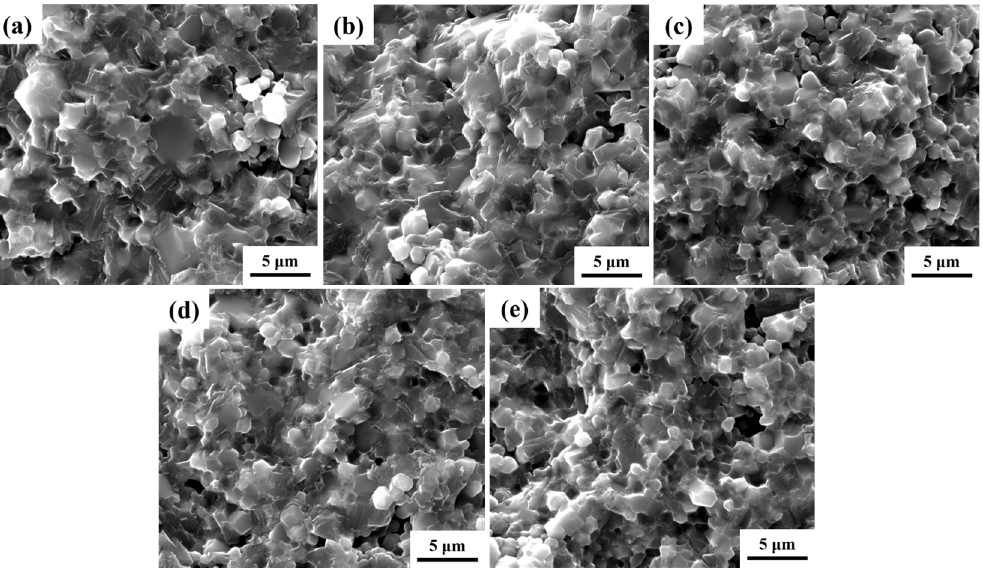
Figure 2. SEM images of the fractured surface of the as-prepared ceramics: ( a ) CCTO; ( b ) SrZr1; ( c ) SrZr2; ( d ) SrZr3; ( e ) SrZr4.